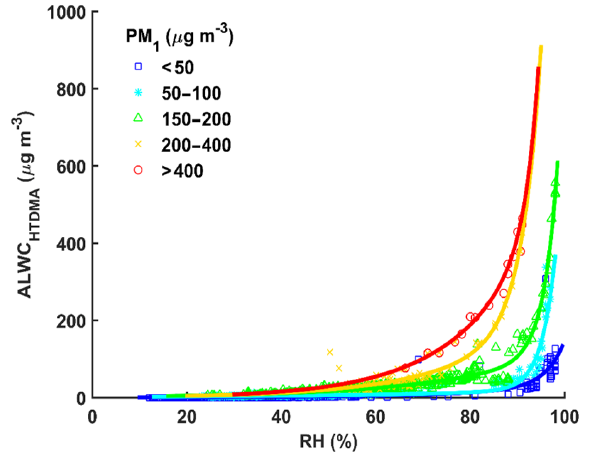
Figure 6. The dots show how ALWC HTDMA varies with the am- bient relative humidity (RH) for different PM 1 mass concentration ranges (colored symbols). The colored curves represent the best-fit lines through the data using the fitting function y = ae bx .